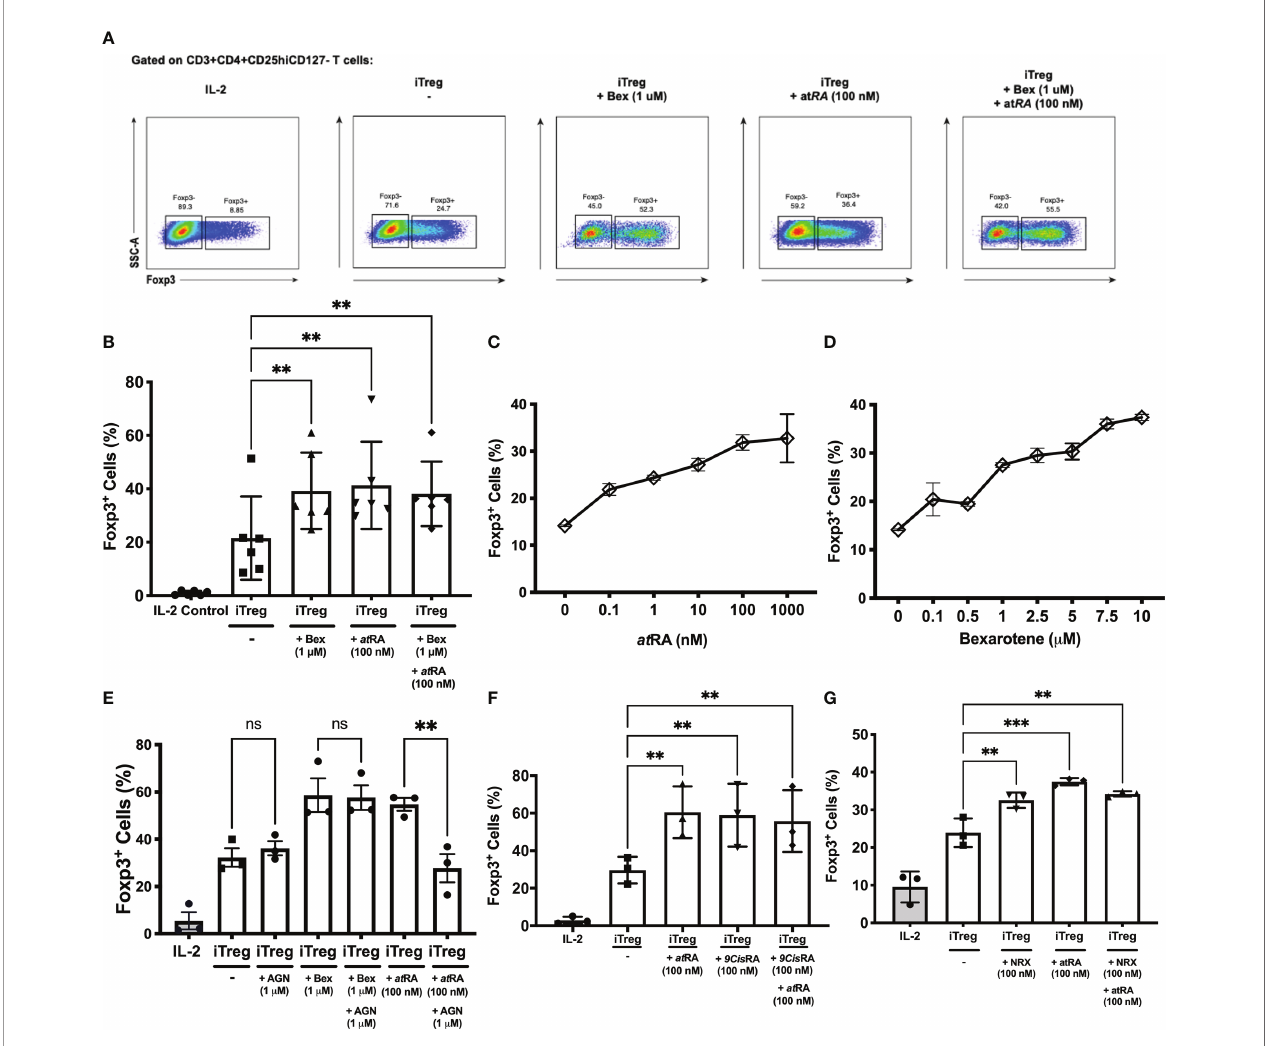
FIGURE 1 | RXR agonists promote human iTreg differentiation independent of RAR signaling. (A) Gating strategy and example dot plots showing iTreg induction following culture of nai ̈ ve T cells for 7 days in iTreg skewing conditions +/- bexarotene (1 m M), +/- atRA (100 nM) or both (B) Summary data for n=6 experiments (C, D) percent iTreg induction over a range of atRA and bexarotene concentrations. (E) Co-culture with the RAR antagonist AGN reverses increased iTreg induction seen in the presence of atRA, but not Bexarotene. (F, G) The RXR agonists 9CisRA and NRX194204 also promote human iTreg differentiation in vitro . Shown are mean values ± SEM. Signi fi cance calculated using a repeated measures one-way ANOVA. S ̌ ida ́ k ’ s correction was performed. *p < 0.05, **p < 0.01, ***p < 0.001 ns, not signi fi